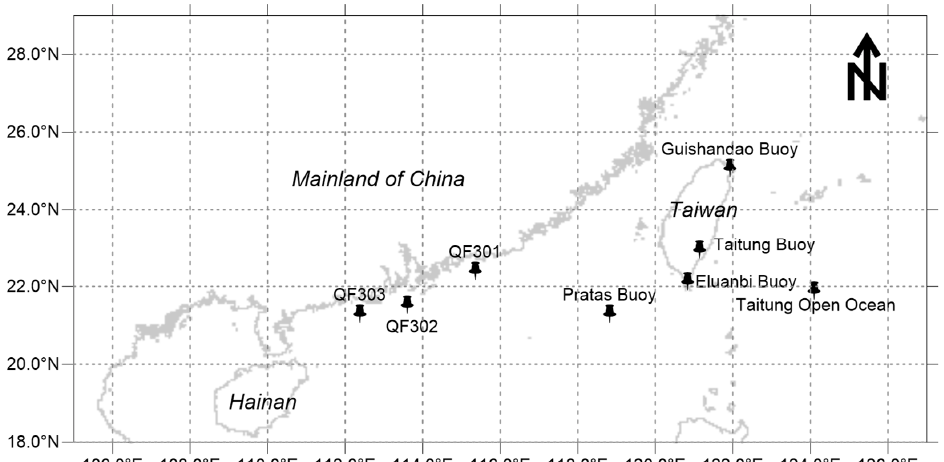
Figure 1. Geographical location of wave buoys for model verification (QF301–QF303 are from some discontinuous scientific projects; others are from the Central Weather Bureau of Taiwan (CWBT)